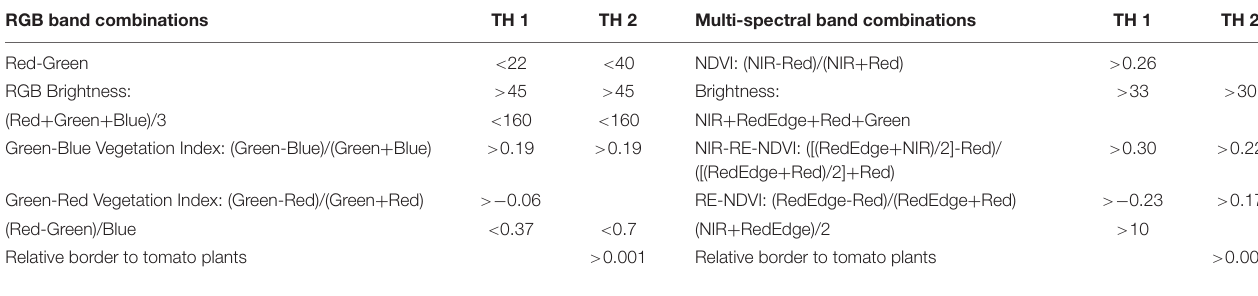
TABLE 1 | Band combinations and associated thresholds (TH) used for the initial tomato plant identification in the object-based image analysis for the RGB and multi-spectral UAV imagery. RGB band combinations TH 1 TH